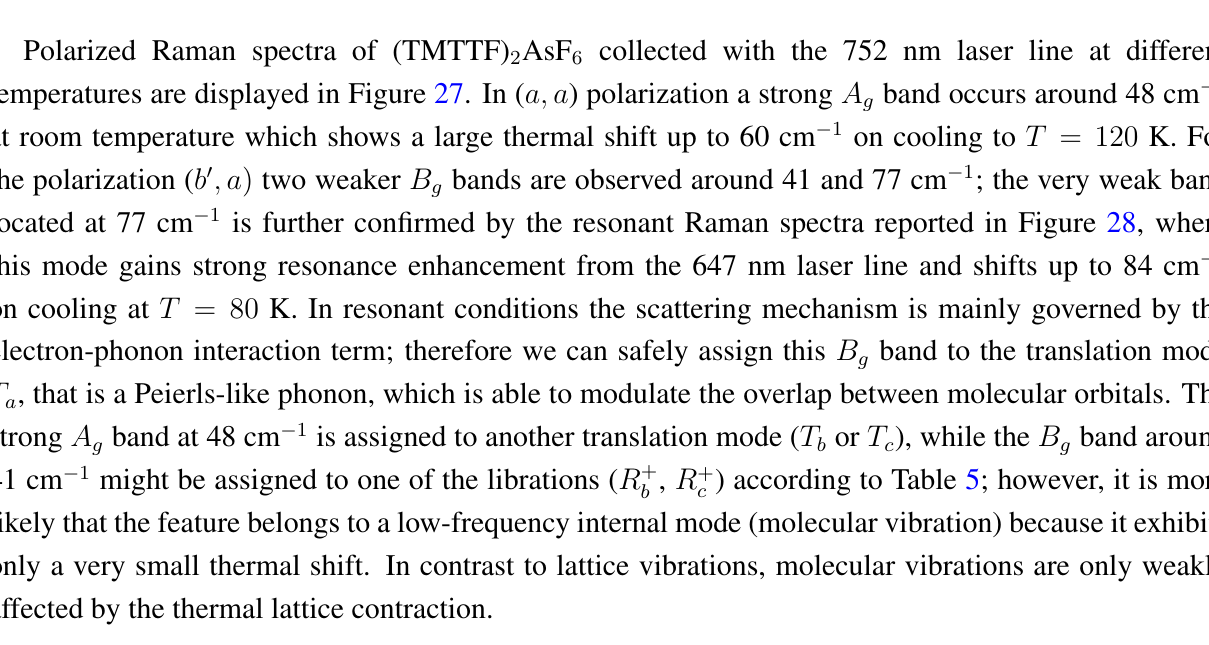
PF at different temperatures 2 6 . On the right side the reflectivity at T = 6 and 20 K CO